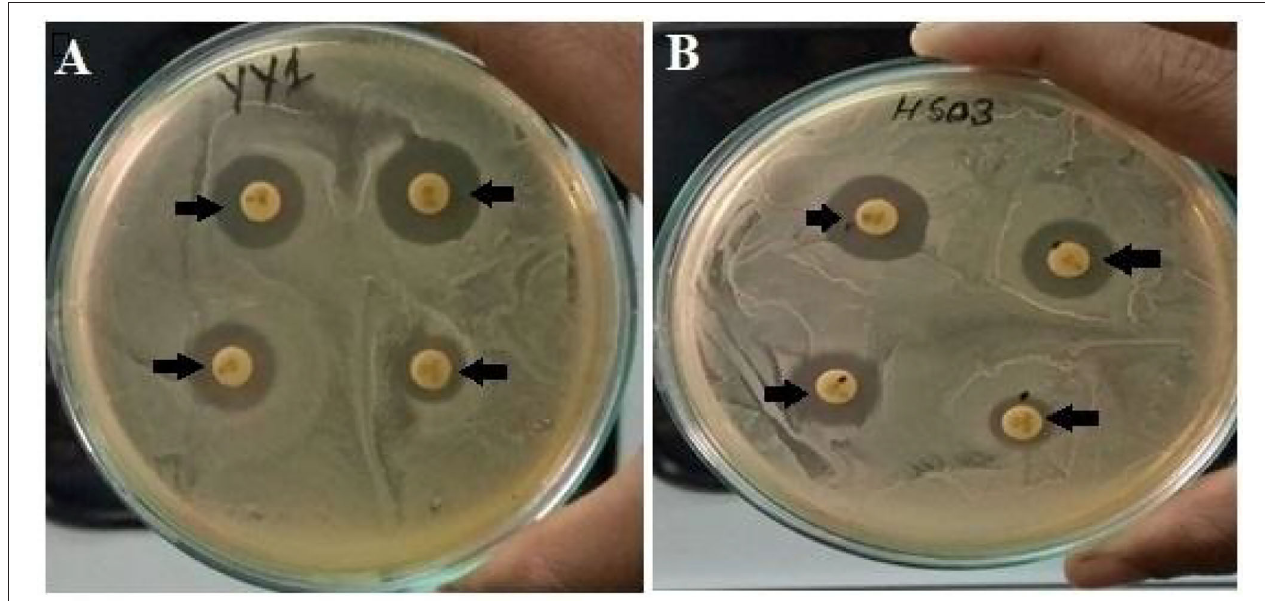
FIGURE 2 | (A) Antibiotic sensitivity pattern of Enterococcus lactis YY1 and (B) Enterococcus durans HS03.